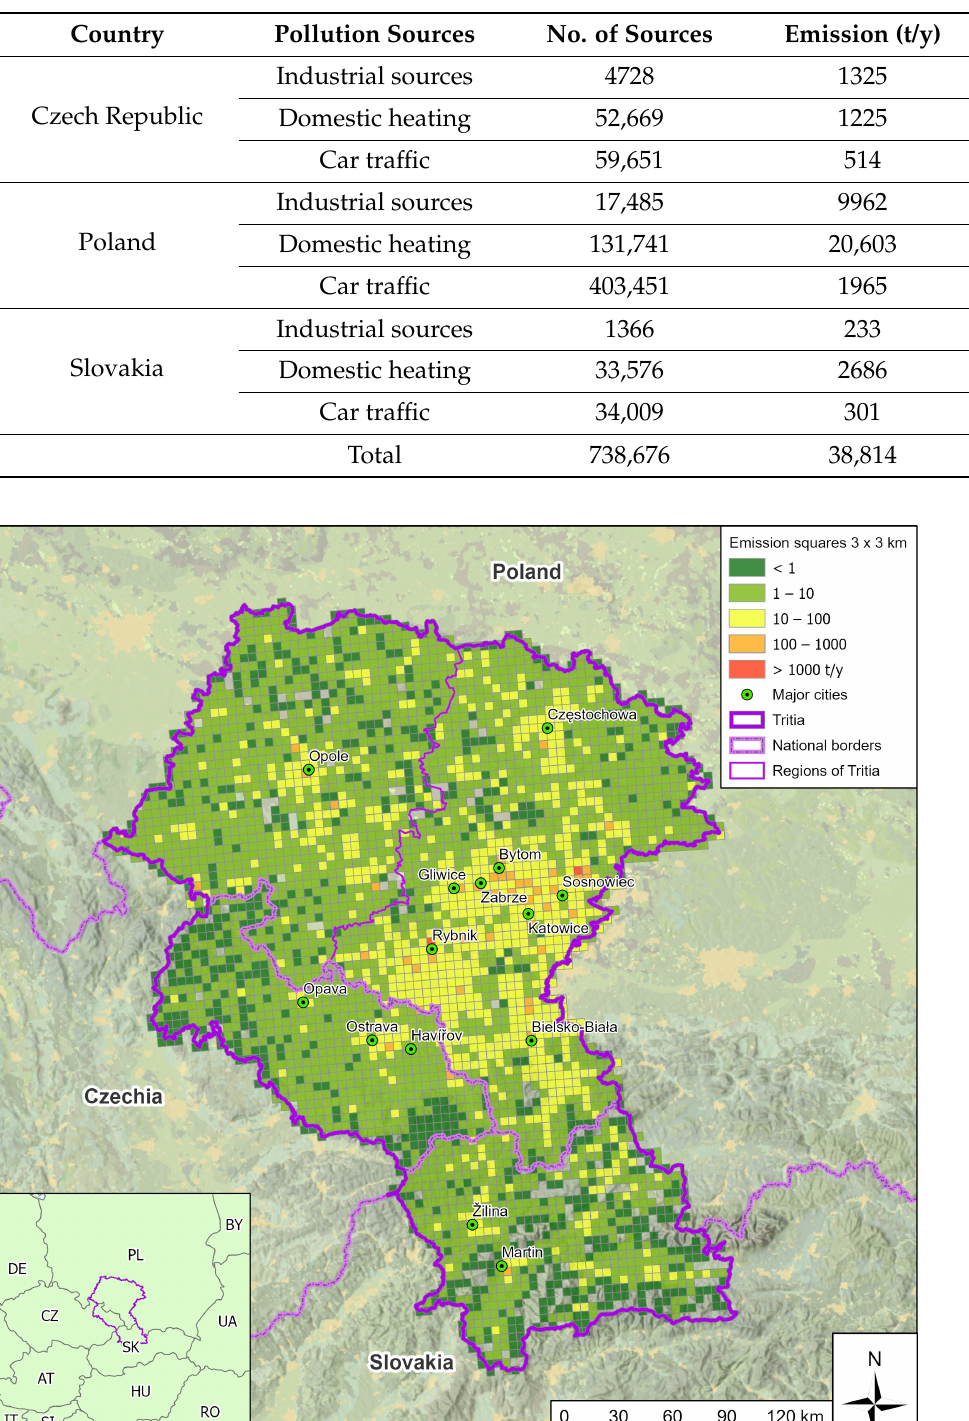
Table 1. Emission of PM 10 in the area of interest.